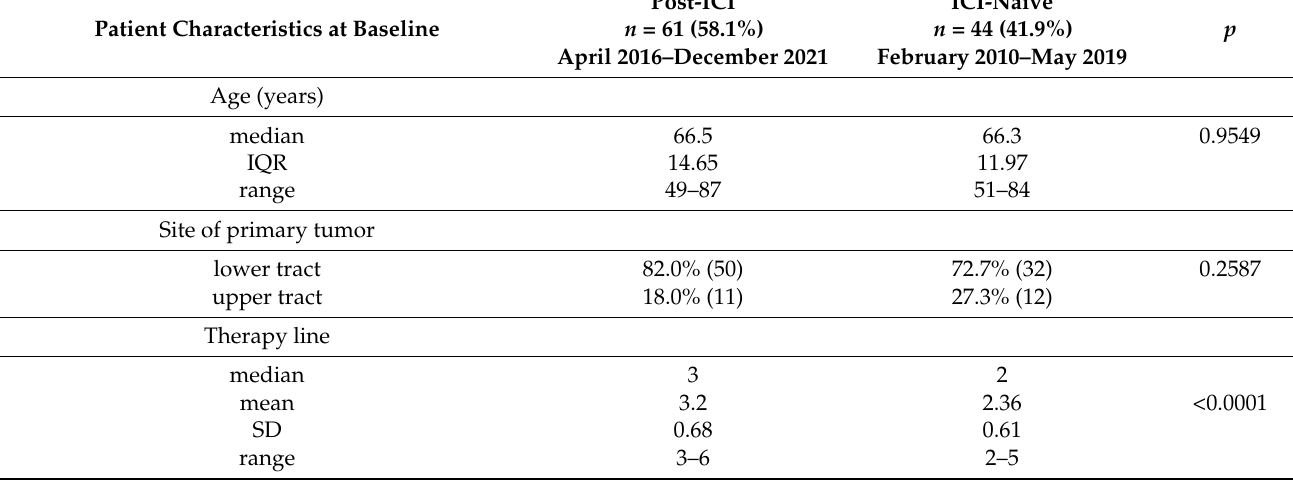
Table 1. Patient characteristics at